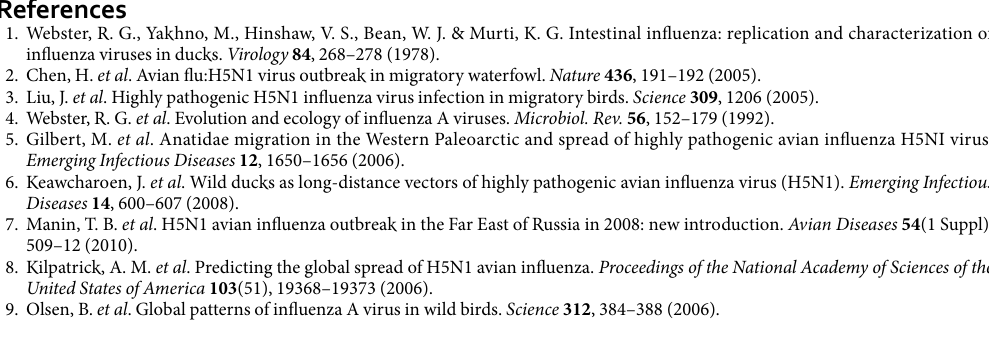
using discrete location data obtained at relatively short time intervals, which is the probability of being in an area during the time of observation that is conditioned on starting and ending locations. We calculated all whooper swan output grids at the same spatial extent and at a 200 × 1000 km 2 grid resolution. We plotted and analyzed migration routes, time, and days at stopovers using ArcGIS version 10.2 (ESRI, Redlands, California, USA). We set up 80 random points in the study area, and the ratio of random points to H5N1 events is 10 to 1. We used spatial analysis techniques for H5N1 events and random points in 95%, 99% and 100% of the home range by logistic regression in SPSS 20.0. Ethics statement.